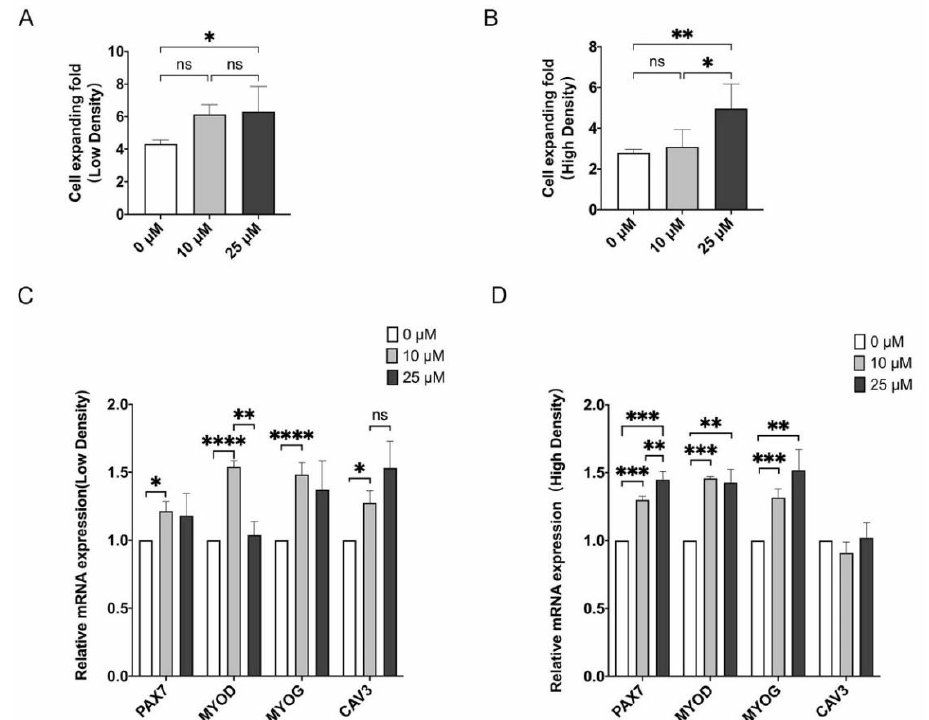
Figure 4. LPA promotes MuSCs proliferation and up-regulates myogenic genes. MuSCs were plated at low and high-density culture conditions. On the second day, cells were treated with 10 µ M or 25 µ M LPA and harvested after another 24 h. ( A , B ) The cell expansion ratio at low or high seeding densities with or without LPA treatment. ( C , D ) Expression by qPCR of PAX7 , MYOD , MYOG , CAV3 in MuSCs cultured with LPA under low or high-density conditions. Mean ± SD from three independent experiments. Significance was analyzed by ANOVA with Fisher’s protected least significant difference (PLSD). * p < 0.05, ** p < 0.01, *** p < 0.001, **** p < 0.0001, ns, not significant ( p > 0.05).